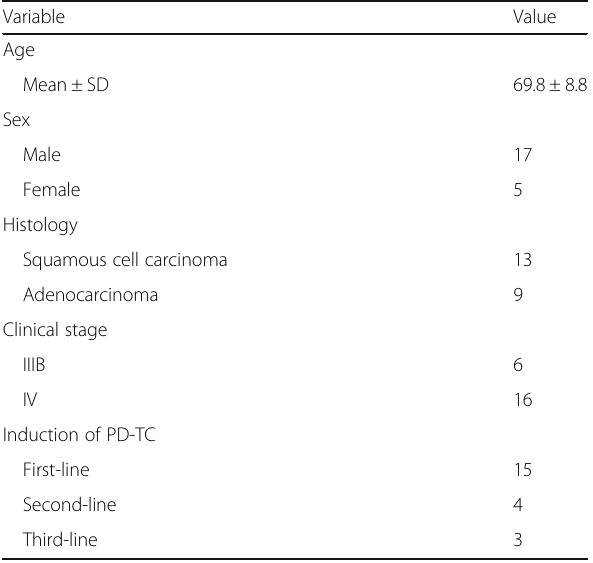
Table 1 Patient